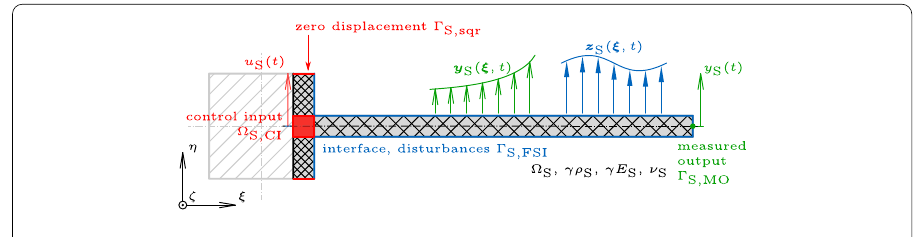
Fig. 6 Computational structural mechanics high fidelity